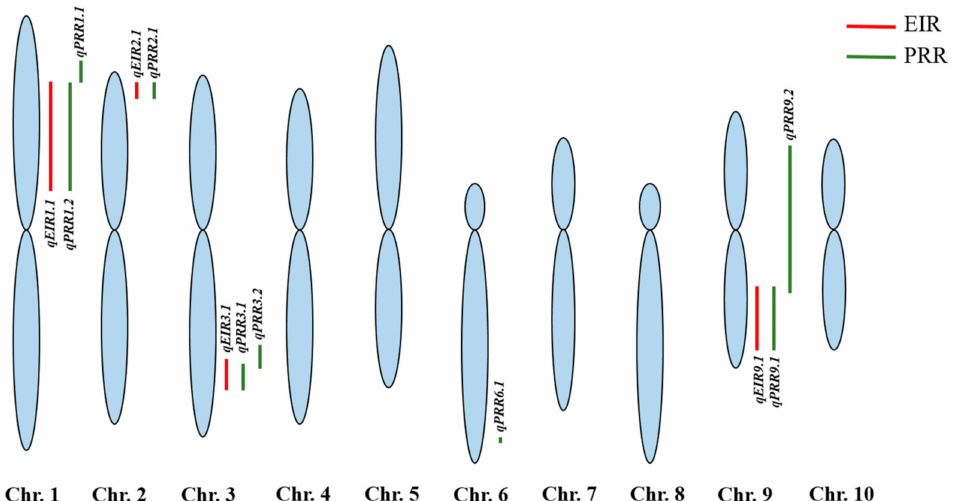
Figure 5. Distribution of somatic regeneration quantitative trait loci (QTLs) on maize chromosomes. The red and green bars represent QTL intervals of the EIR and PRR, respectively. Chr.: